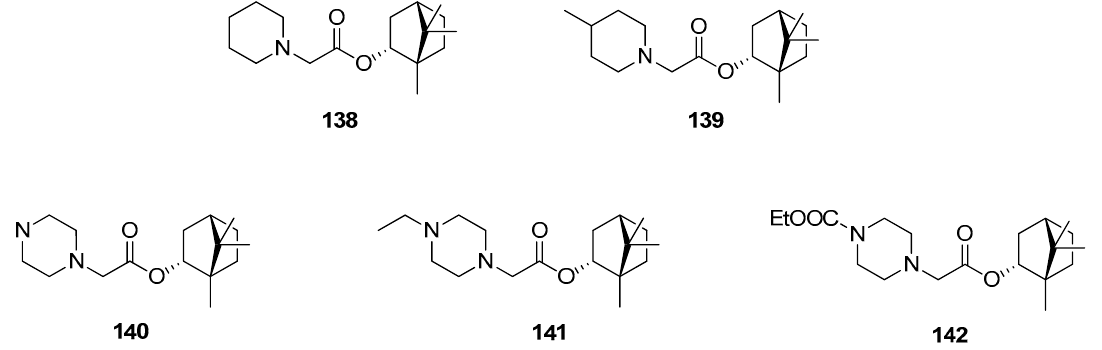
Figure 40. N -Heterocyclic esters of (–)-borneol derivatives as antiulcerogenic agents.